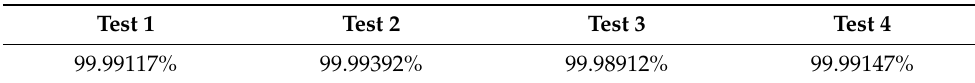
Table 9. Efficiency 2 : Results from four tests for the cycle list model. Test